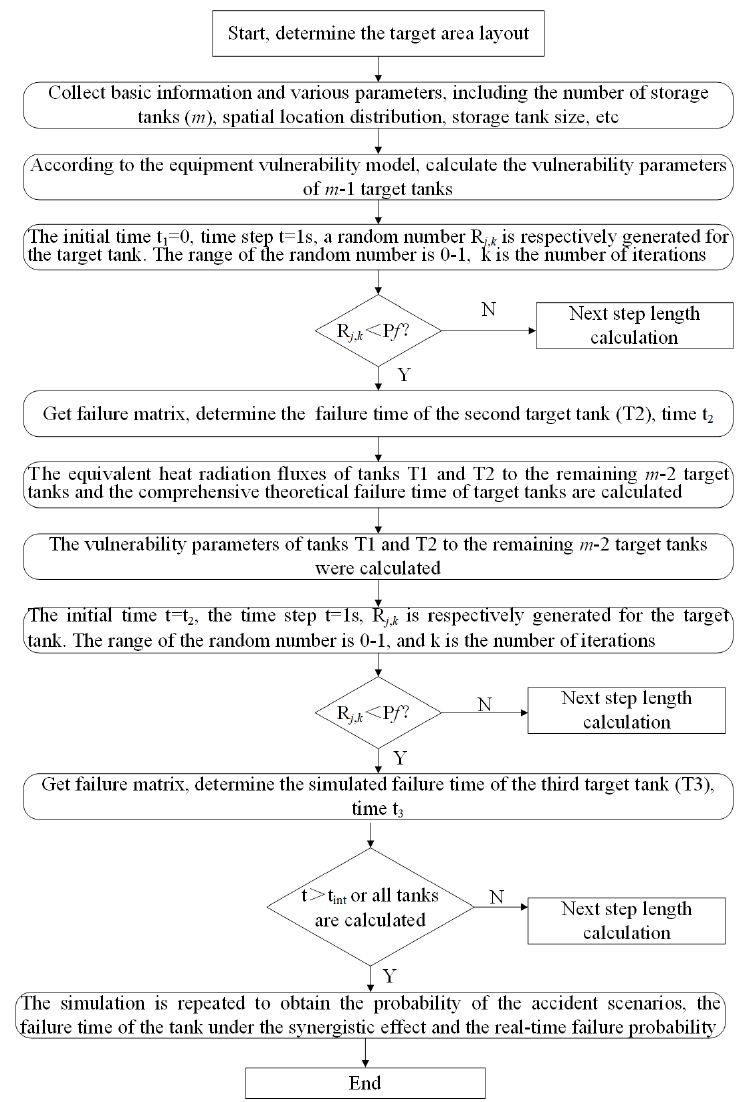
Figure 1. The flowchart of the method based on the Monte Carlo algorithm.